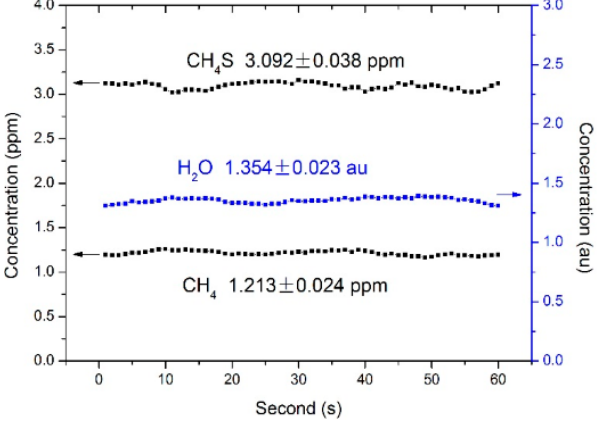
Figure 6. Successive measurements with 1 s intervals for a gas sample with a duration of 1 min.